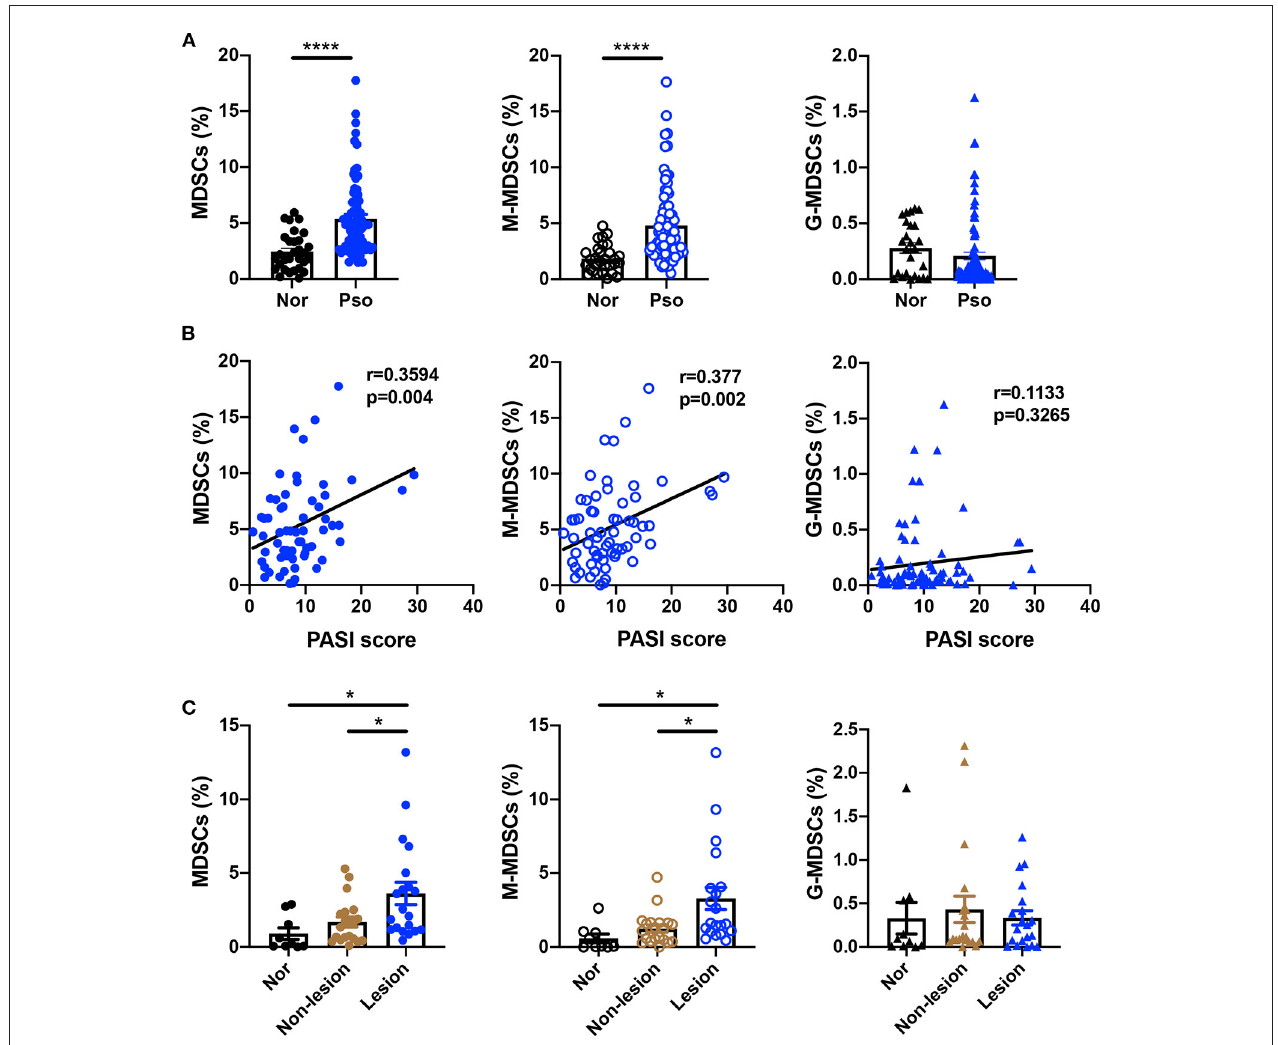
FIGURE 1 | MDSCs and M-MDSCs expansion was found in the peripheral blood and skin lesions of psoriasis patients. (A,B) (A) Percentages of HLA-DR − CD11b + CD33 + MDSCs (left panel), HLA-DR − CD11b + CD33 + CD15 − CD14 + M-MDSCs (middle panel), and HLA-DR − CD11b + CD33 + CD15 + CD14 − G-MDSCs (right panel) in PBMCs of healthy controls (Nor) ( n = 30) and plaque psoriasis (Pso) ( n = 77), and (B) the correlation analysis between the indicated cells frequency and disease activity (that is, PASI score) in plaque psoriasis. (C) The number of MDSCs (left panel), M-MDSCs (middle panel), and G-MDSCs (right panel) in normal skins ( n = 9), non-lesion tissues ( n = 20), and skin lesion of psoriasis ( n = 20). Data represent the mean ± SEM. * p < 0.05, **** p <